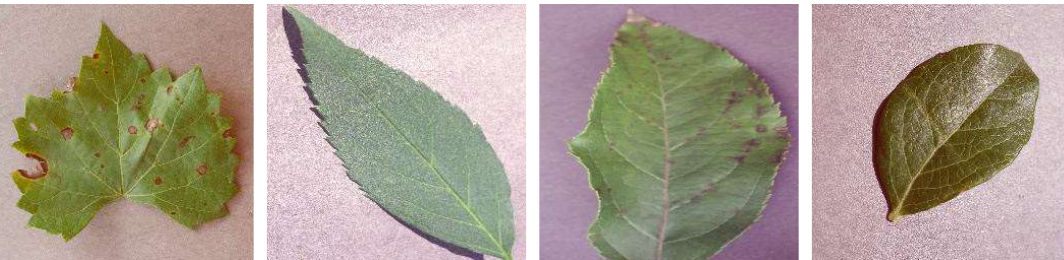
Figure 7. Sample augmented images using the PCA color augmentation technique.